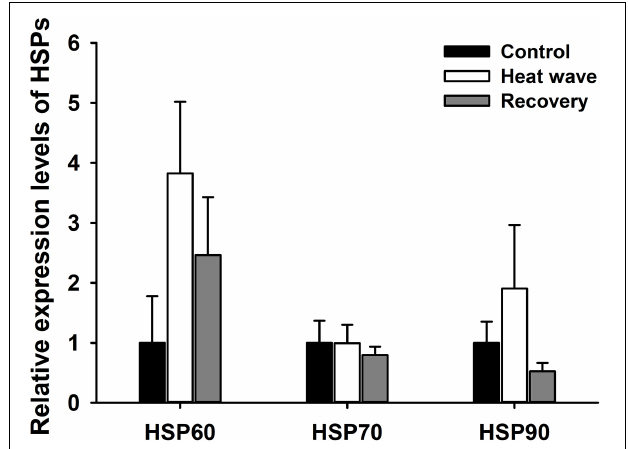
FIGURE 5 | Effect of heat wave on the relative expression levels of HSP60, HSP70 and HSP90 mRNA in liver of Mauremys mutica. Data were represented as mean ± standard error